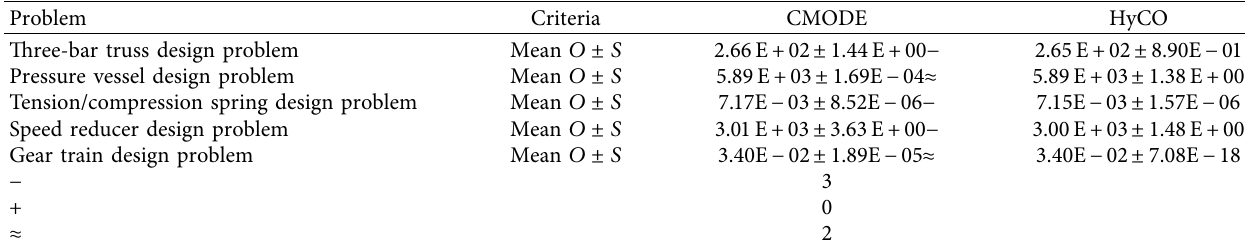
Table 10: Experimental results of HyCO and CMODE for five engineering design problems. Problem